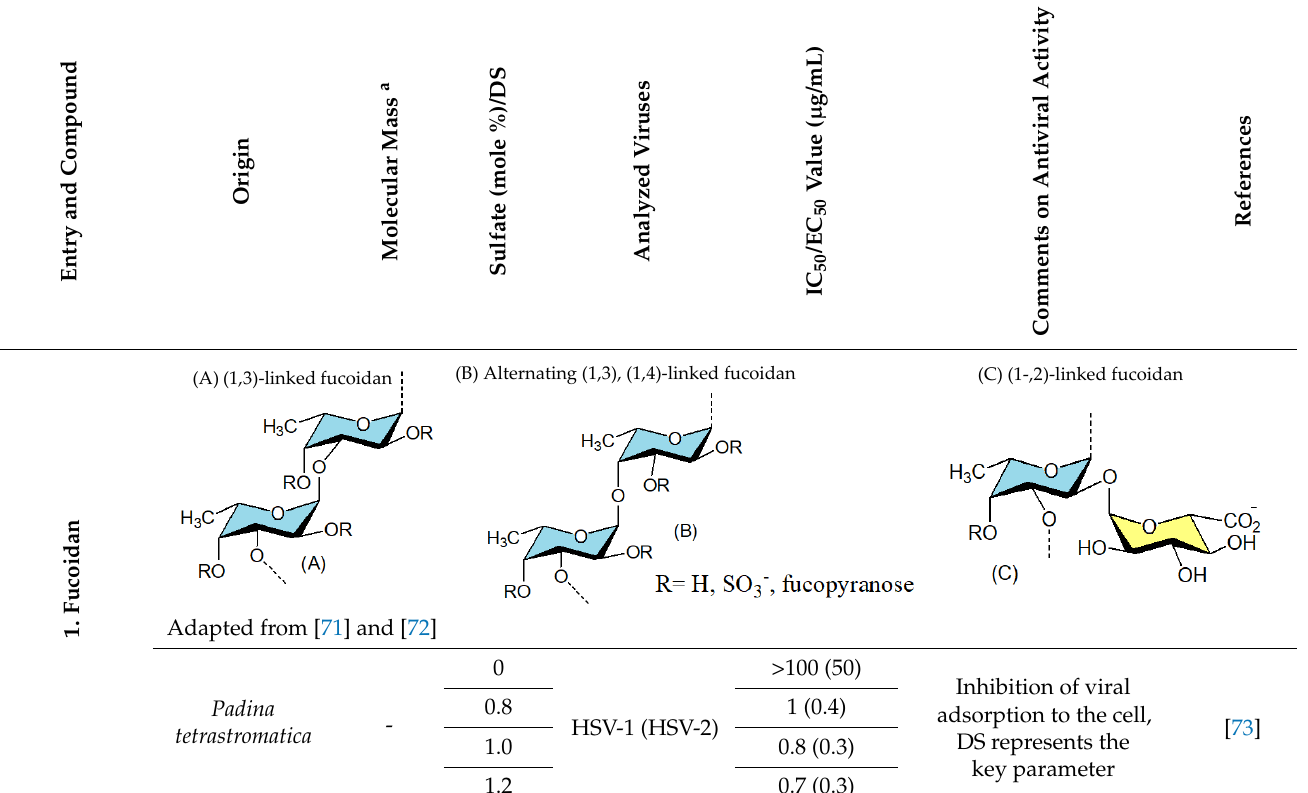
Table 1. Naturally occurring sulfated polysaccharides: molecular masses, sulfate contents (mol %) and their half-maximal inhibitory in vitro/effective concentrations (IC 50 , EC 50 ) referring to the indicated viruses.